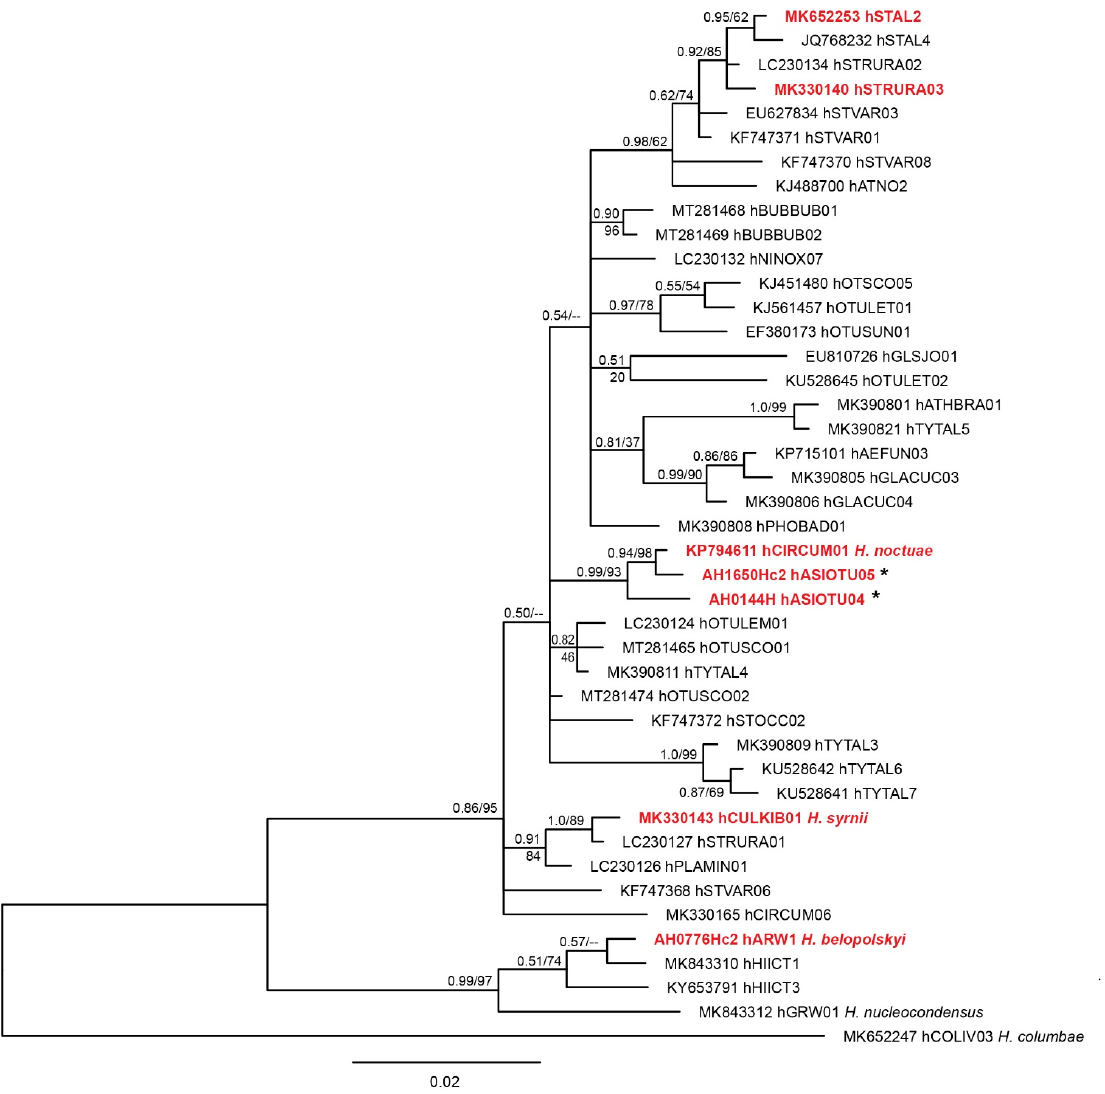
Figure 1. Bayesian Inference tree of 47 partial (474 bp) Haemoproteus cytB lineages. Lineages found in the present study are presented in red bold font. All but one lineage (hARW1) clustered within a clade featuring multiple lineages from owls. The latter (regular letters) were included in the analyses, but approximately 100 lineages from non-strigiform birds clustering in this clade were excluded a priori. For comparison, three lineages closely related to lineage hARW1 were also included. A sequence of Haemoproteus columbae hCOLIV03 was used as outgroup. Lineages found for the first time are marked with an asterisk. Bayesian inference posterior probabilities and Maximum-likelihood bootstrap values are indicated at each node. The scale bars indicate the expected number of substitutions per site according to the model of sequence evolution applied. GenBank accession numbers are provided, followed by lineage names according to MalAvi database (http://130.235.244.92/Malavi/, accessed on 6 July 2022). In case the lineages were linked to morphospecies, the taxon name is